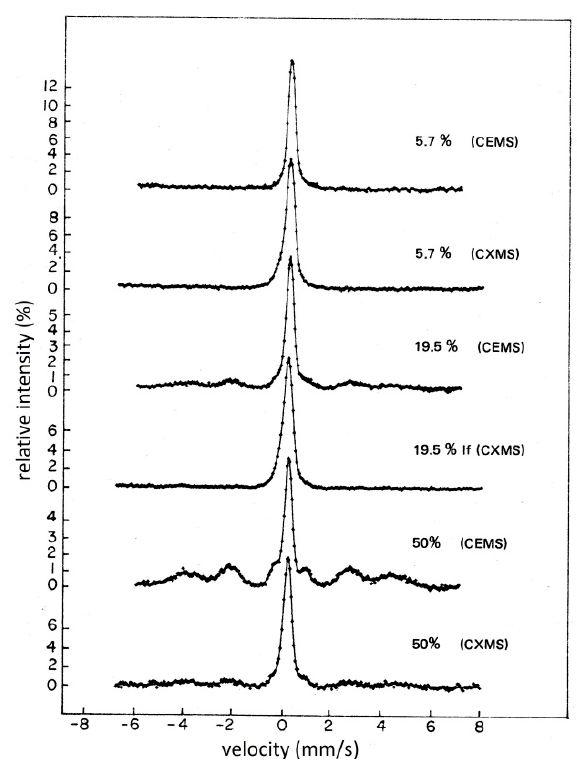
Figure 12. Transmission Mössbauer spectra before (a) and after (b) cold deformation of a Cu sample containing originally only γ -Fe precipitates. Reproduced from [27] with permission of World Scientific, 1958.